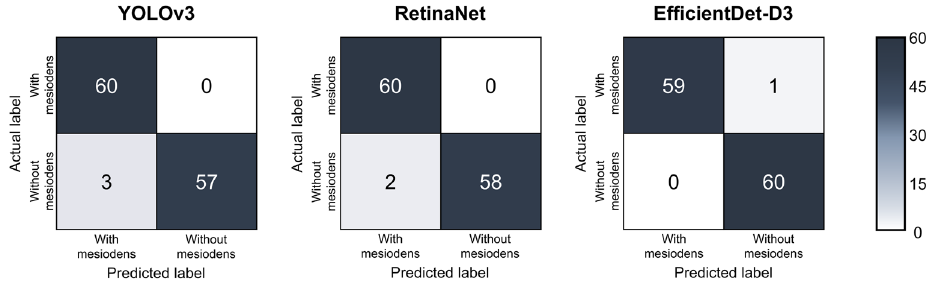
Figure 5. Confusion matrices of the test dataset for the three models.